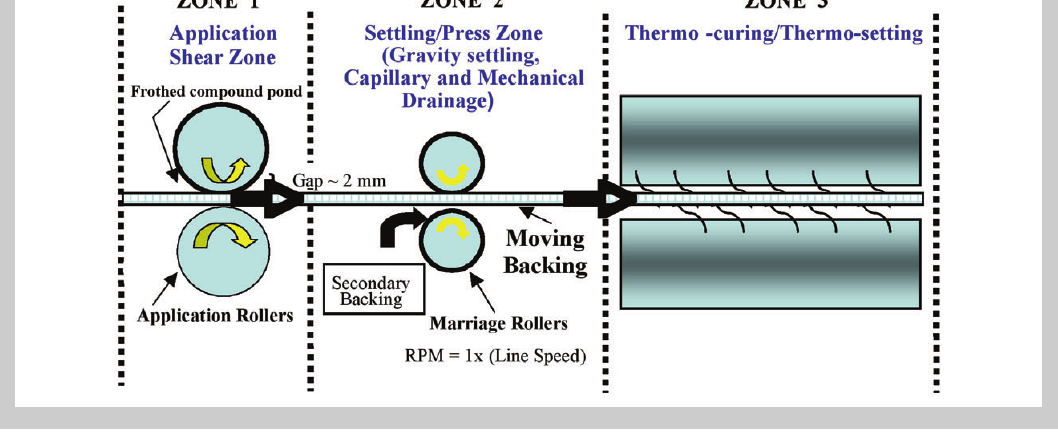
Figure 1: Conceptual model of appli- cation, pressing, and drying of carpet